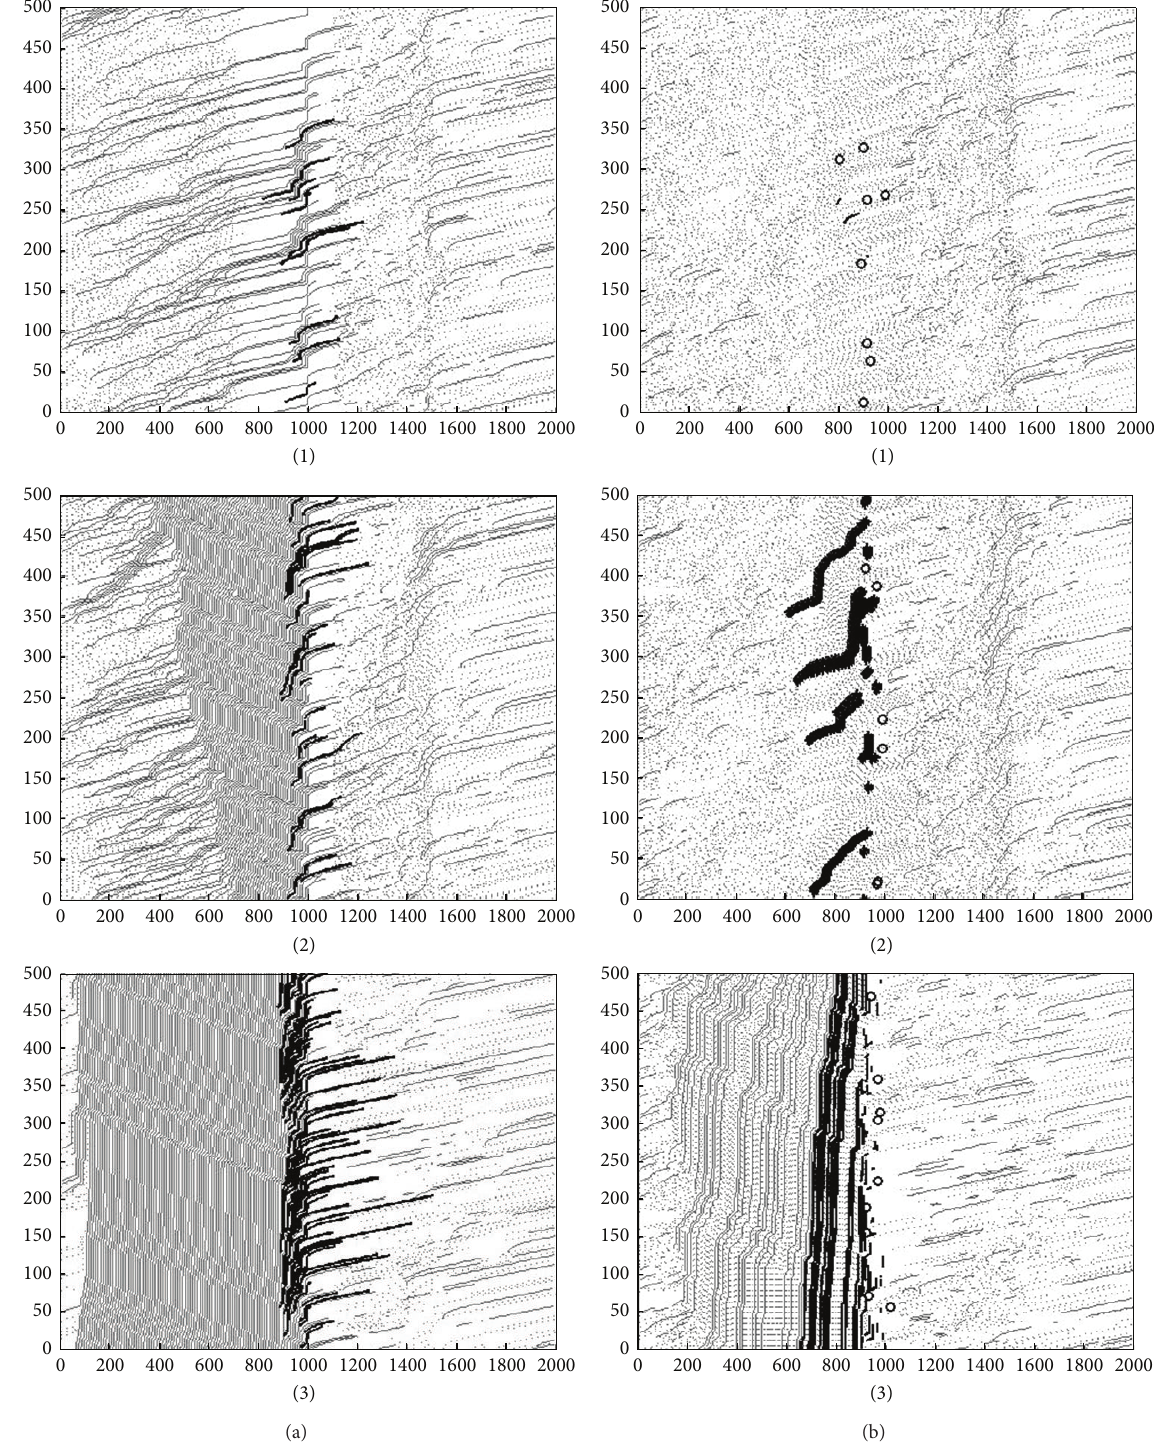
Figure 5: Space-time diagram over 500 time steps. Horizontal axis is for position and vertical axis is for time. (a) is for lane 1 and (b) are for lane 2. The first row: 𝑅 = 0.15 , the second row: 𝑅 = 0.2 ; the third row: 𝑅 = 0.3